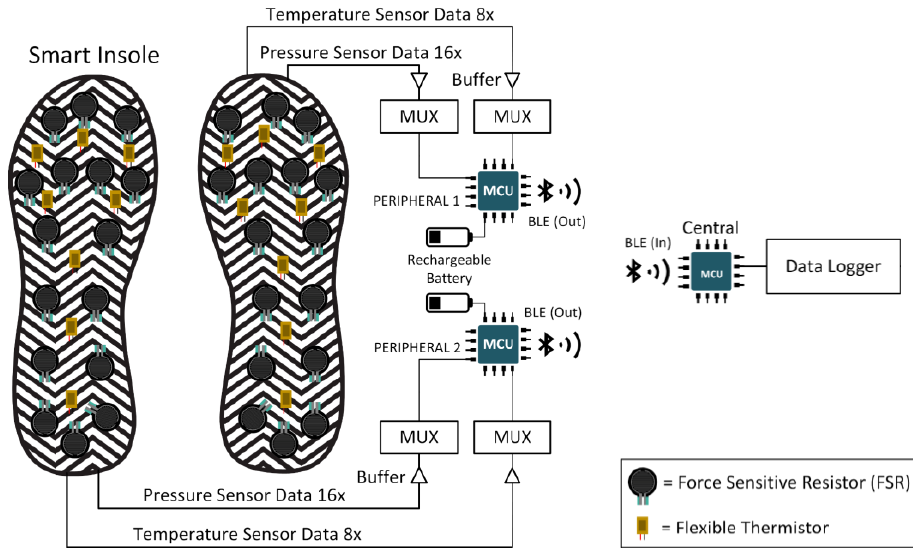
Figure 1. Compete system block diagram.